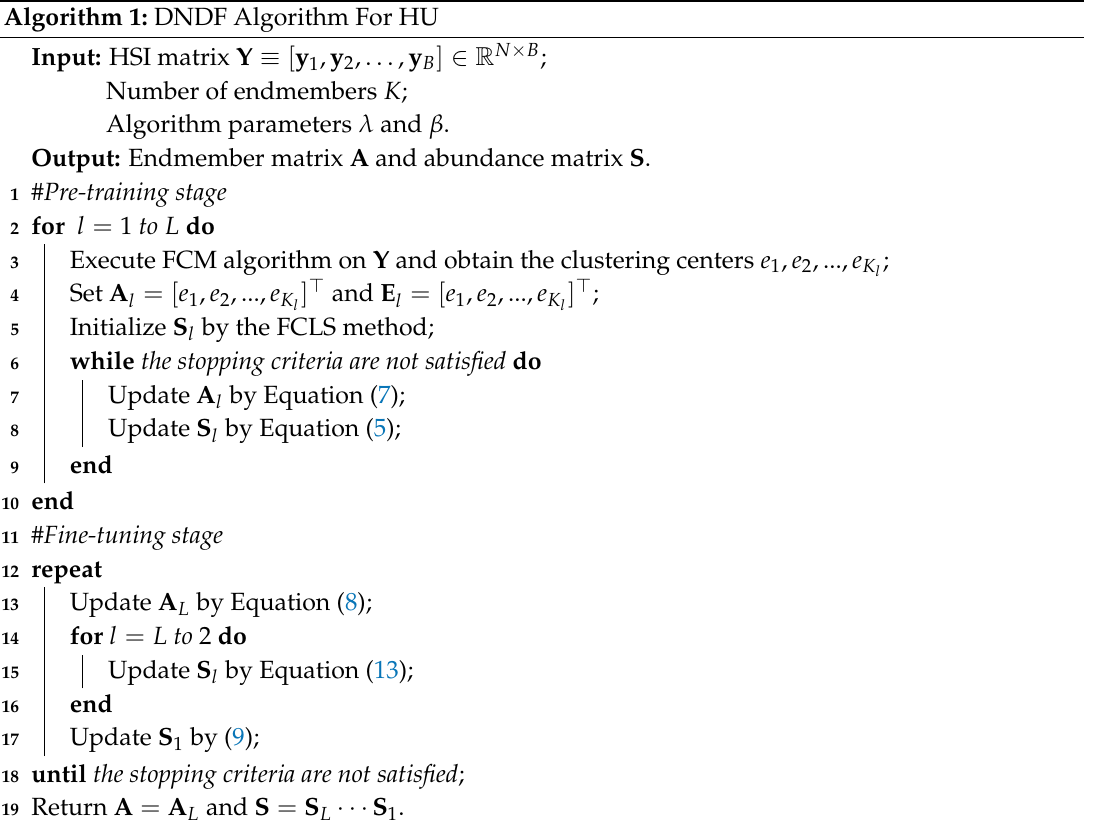
Algorithm 1: DNDF Algorithm For